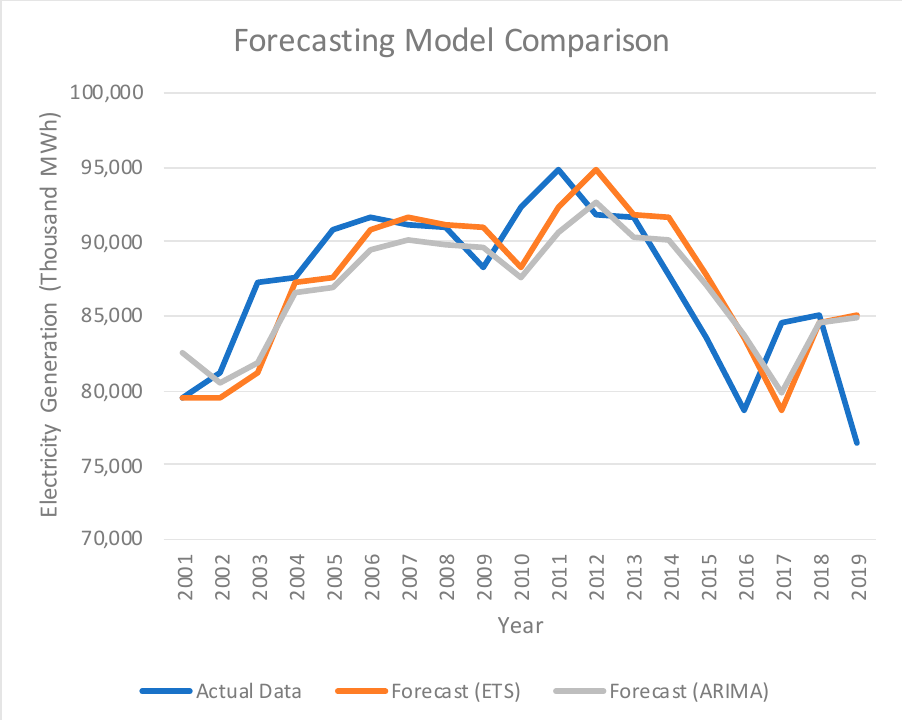
Figure 2. Forecasting Model Comparison.